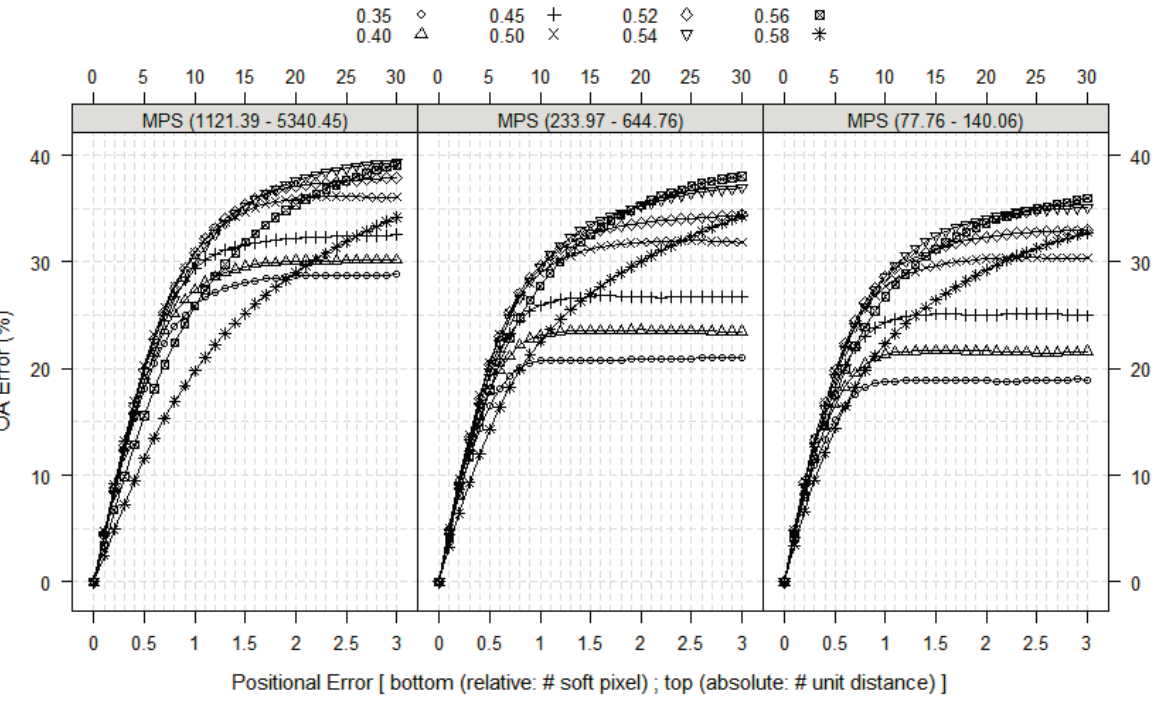
Figure 6. Impact of positional error on OA-error at different landscape characteristics using a spatial resolution of 10 unit